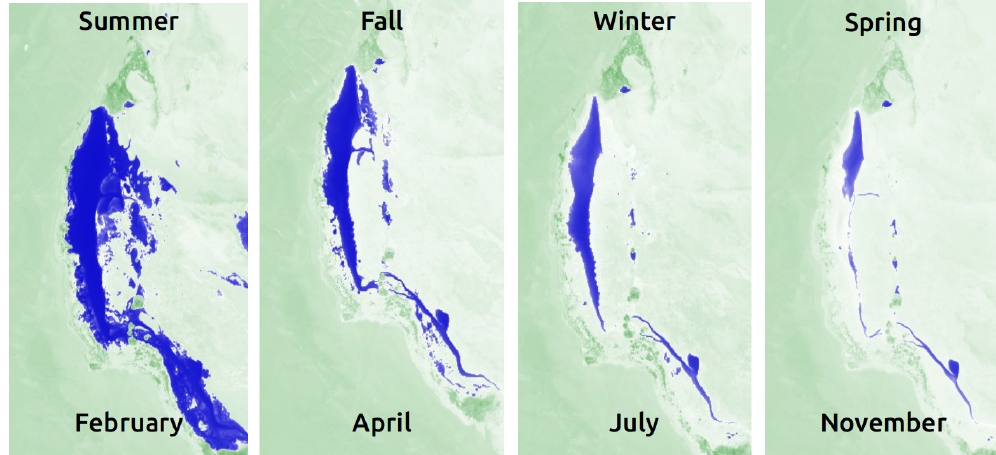
Figure 1. Shallow saline lake at Salar del Huasco as viewed by the normalized difference water index (NDWI) from Copernicus Sentinel data from 2019 processed by Sentinel Hub. This index combines infrared and visible bands, where dark blue represents water and light green the absence of water. The right-hand image shows the extent of the lake on 18 November 2018, during the field measurements shown in this